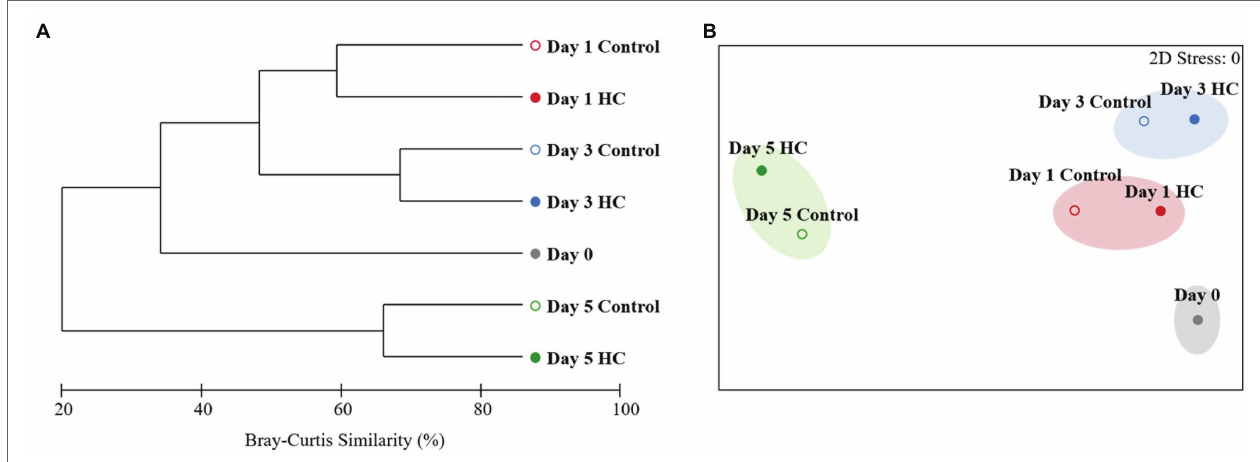
FIGURE 4 | Clustering (A) and non-metric multidimensional scaling (NMDS; B) analyses showing relationships between the bacterioplankton communities in elevated p CO 2 (HC, about 1,000 μ atm, solid circles) and ambient p CO 2 (Control, about 380–410 μ atm, hollow circles) conditions during microcosm experiment. Similarities were based on Bray-Curtis similarity. Samples were clustered at a similarity level of 70% in NMDS